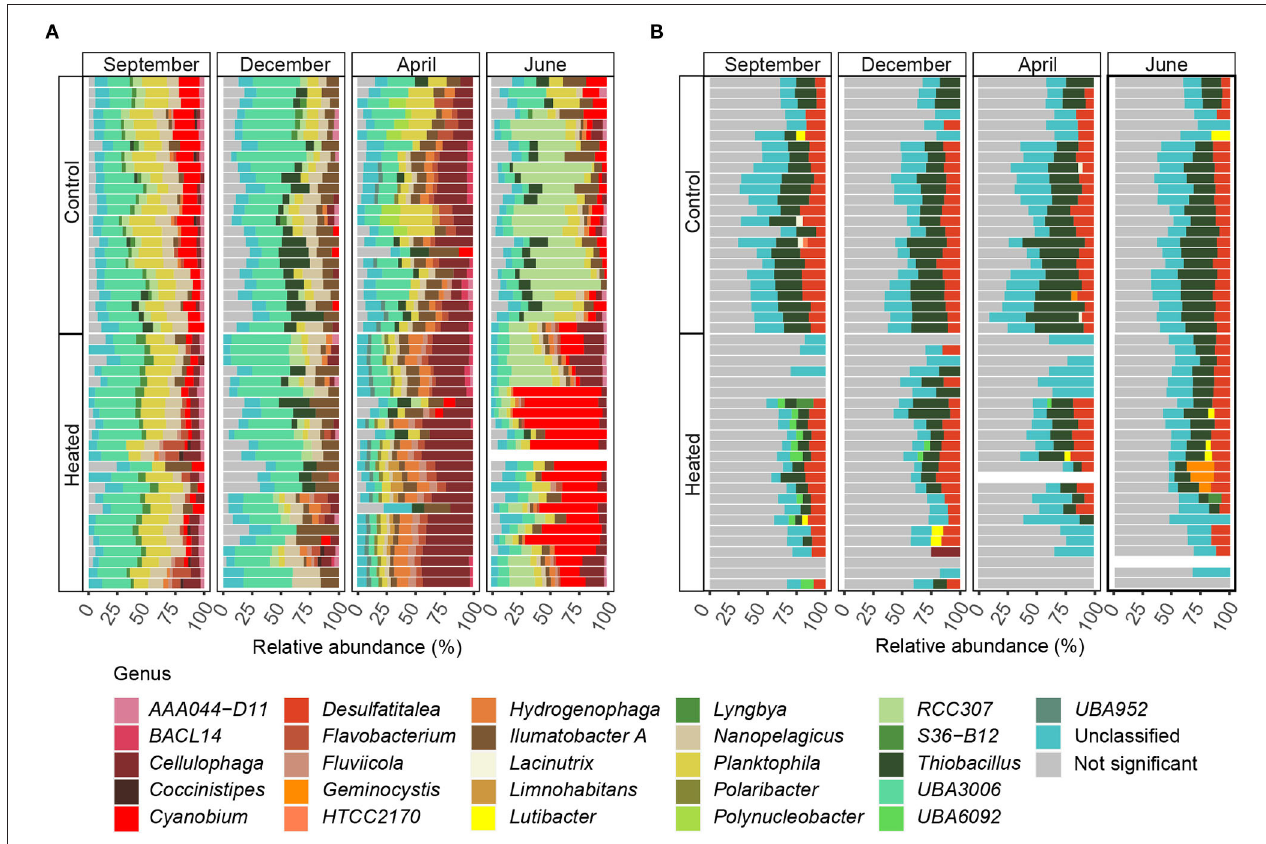
FIGURE 6 | Differentially abundant ASVs summarized mean on the genus level within the top five orders responsible for shaping BW (A) and SED (B) bacterial communities according to SIMPER analysis. Stacked bars of significantly differentially abundant ASVs responsible for differences between the heated and control bays at the different sampling months ( n = 4). The mean relative abundance was calculated on the genus level, and taxa below 1% relative abundance were excluded. Shown are the different sampling sites plus replicates ( n = 24) per bay and month. Nonsignificant differentially abundant ASVs were grouped together. Samples with low read size were excluded (see Materials and Methods). The stacked bars are read from right to